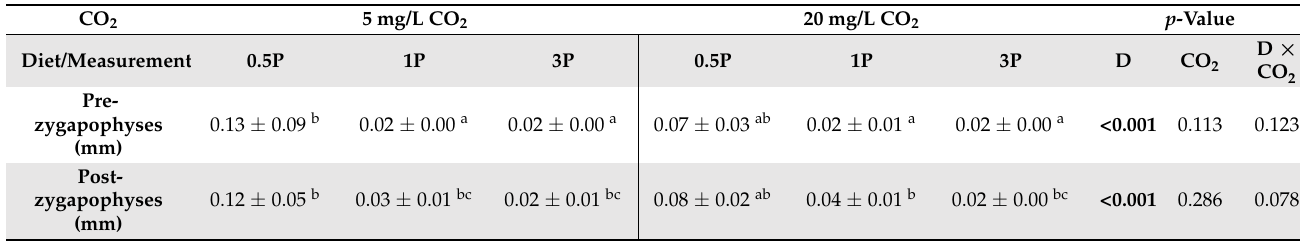
Table 5. Extent of non-mineralized bone in zygapophyses. The analysis was performed on whole mount Alizarin Red S stained vertebral columns of animals fed diets containing different levels of total P 0.5P (6.3 g/kg), 1P (9.0 g/kg), and 3P (26.8 g/kg) and reared in conditions with no CO 2 injected (5 mg/L) or with injected CO 2 (20 mg/L). The extent of non-mineralized bone on both pre-zygapophyses and post-zygapophyses was significantly increased in 0.5P/5CO 2 animals. The statistically significant differences among groups (within a row) are indicated by different lowercase superscript letters. If none of the letters are the same, differences are significant. The significant values ( p ) for CO 2 , diet (D), and their interaction are